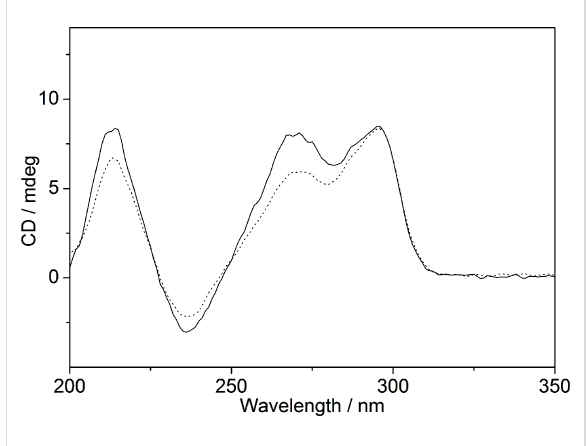
Figure 3: CD spectra of ILPR-sequence a2 (20 µM) in potassium phosphate buffer (95 mM, pH 7.0; __ : immediately after the prepar- ation of the DNA stock solution; ···· : 2 d after the preparation).